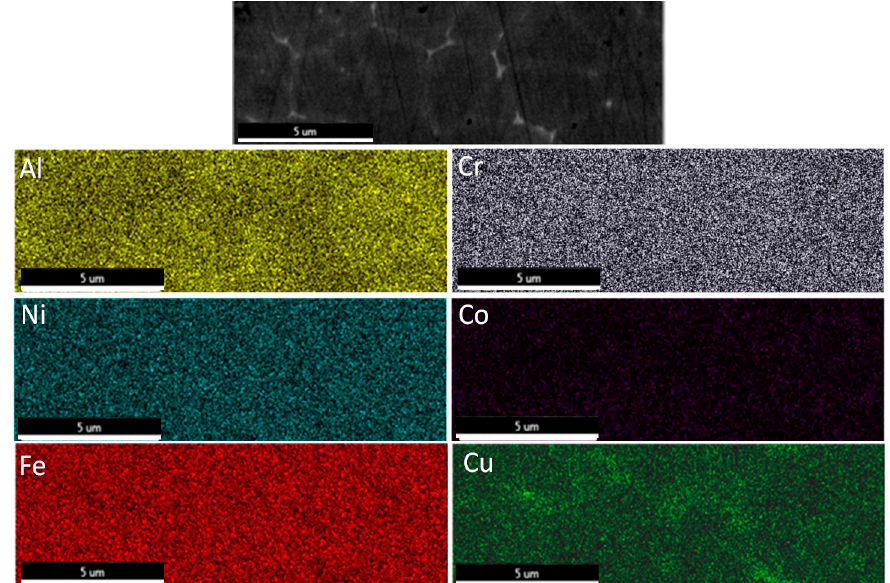
Figure 3. Compositional analysis by EDX of the FeCrCoNiAl 1.8 Cu 0.5 powder particle cross section.